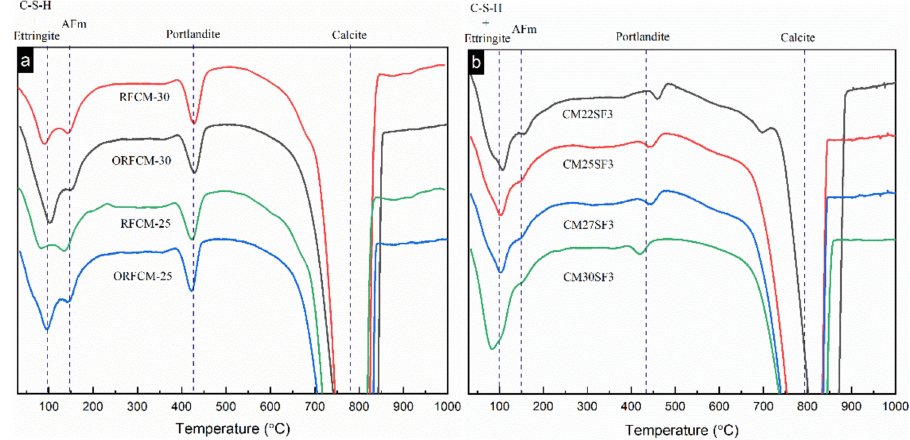
Figure 11. DTG curves of optimized and non-optimized samples ( a ) and samples blended with silica fume ( b ) samples at 90